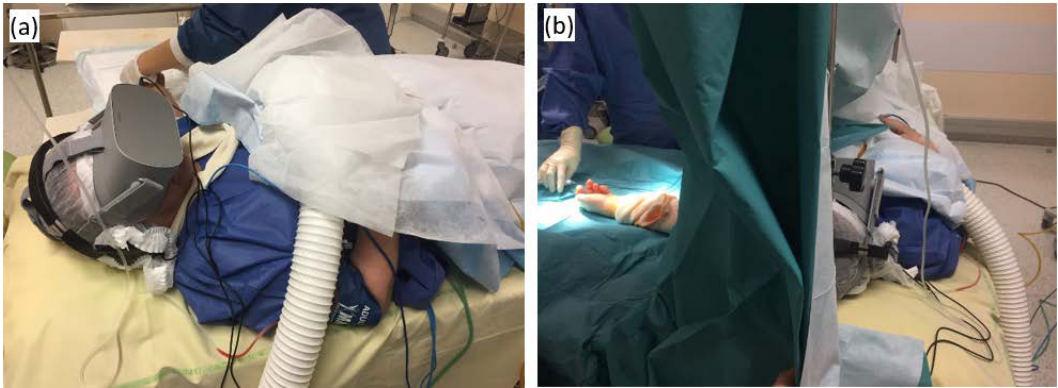
Figure 1. ( a ) Virtual reality helmet set up after installation in the operating room; ( b ) intraoperative virtual reality session.